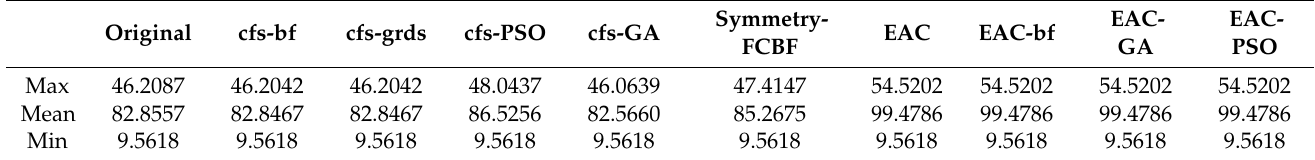
Table 1. Accuracy of the Hoeffding tree model coupled with ten preprocessing algorithms.